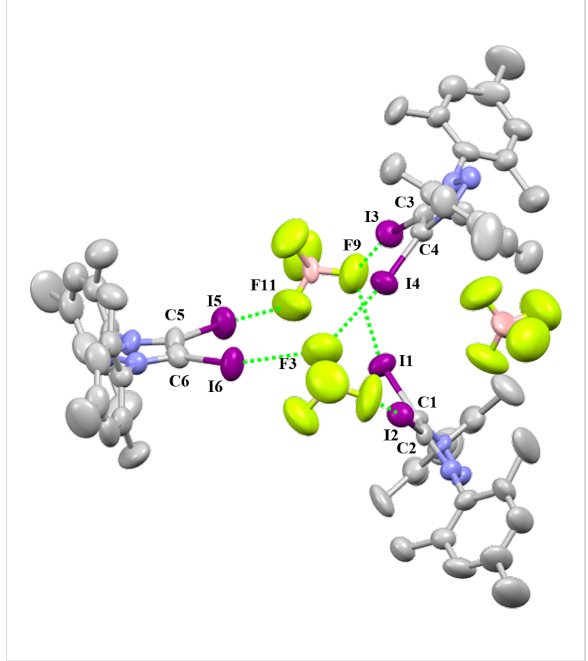
Figure 3: Packing structure of 2-BF 4 . Hydrogen atoms have been omitted for clarity. The single crystal of 2-OAc crystallizes in the monoclinic space group P 2 1 / c . The package diagram shows a dimer which is almost a rectangle (Figure 4). As shown in Table 1, The C–I···O distances are 2.547(2) Å and 2.582(2) Å. The C–I···O angles are 174.60(7)° and 170.38(7)°. The R XB values are 0.72 and 0.73.